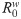
Distribution of the within-flock reproduction number.Histogram of 22 estimated values for the reproduction number R0w.